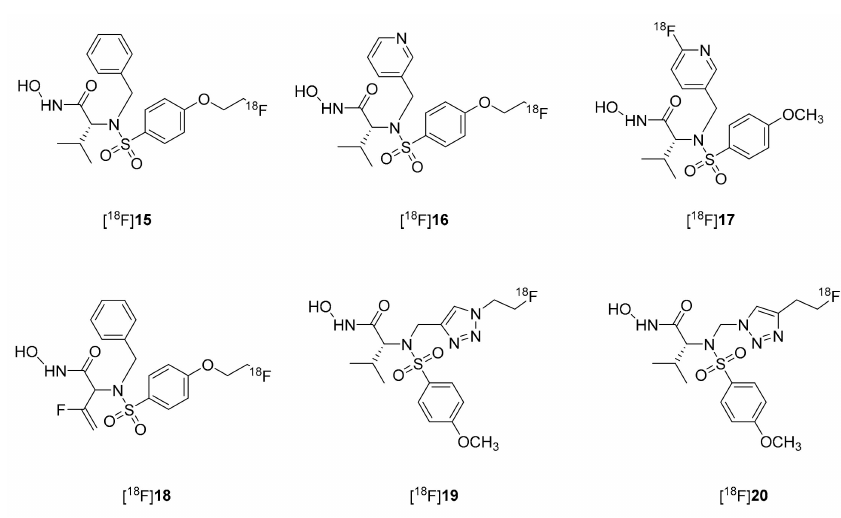
Scheme 2. Chemical structure for compounds 15 – 20